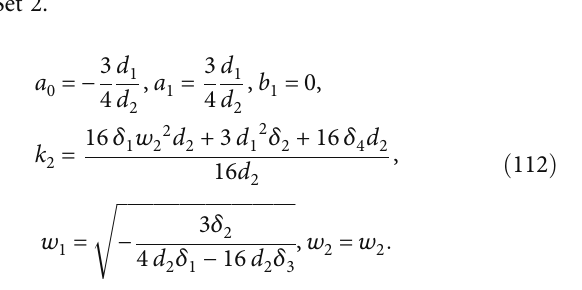
ð x , t Þj for NLFD of order α and for parameters δ 1